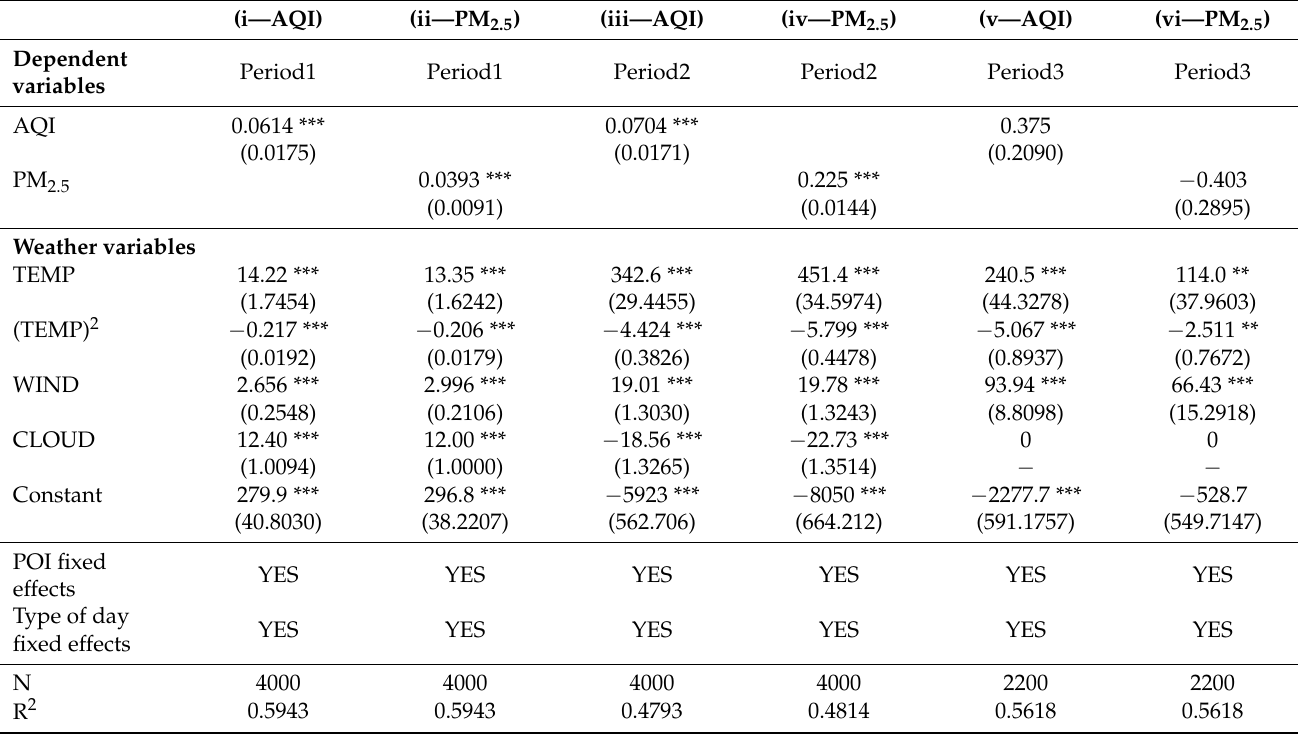
Table A14. Estimation of the effect of air pollution on people’s staying-in activity for the house/community POI.